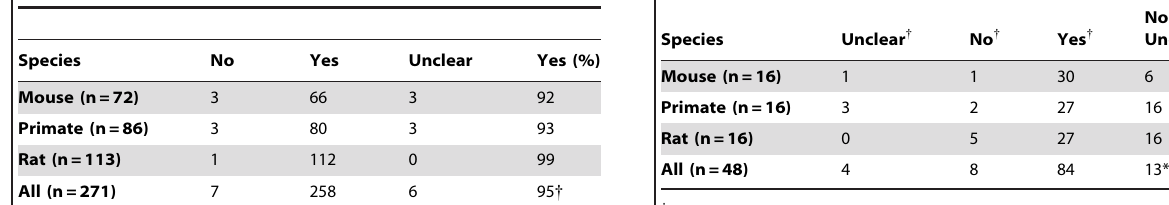
Table 3. Number of studies stating the purpose of the study in the introduction.